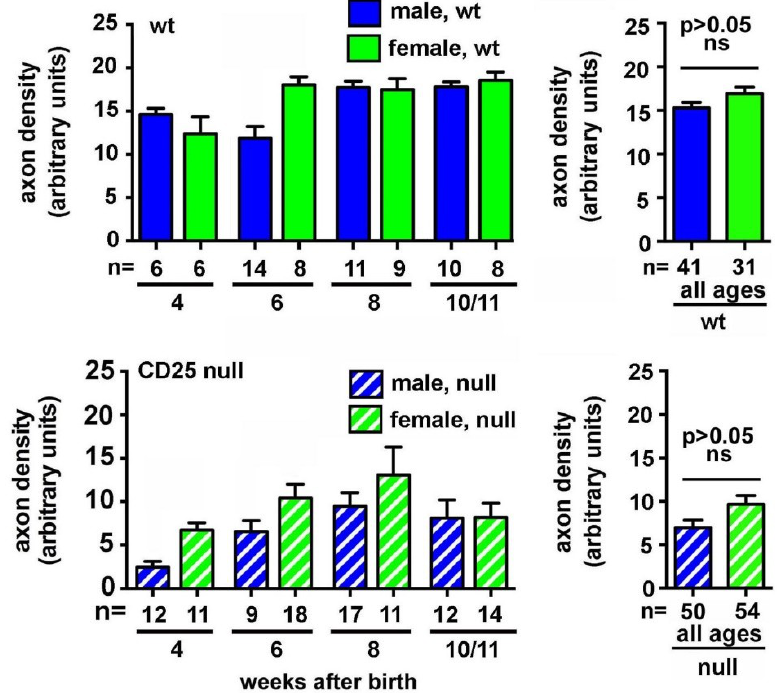
Figure 2. ICN density does not vary significantly between male and female wt and CD25 null mice. ICN density was quantified by Sholl analysis, as described in the methods section. No significant differences are seen between male and female mice at any of the ages studied. Despite a trend for female corneas to have higher axon densities, performing non-parametric t tests on data for males and females after combining all ages also yields p values above 0.05 for both genotypes.